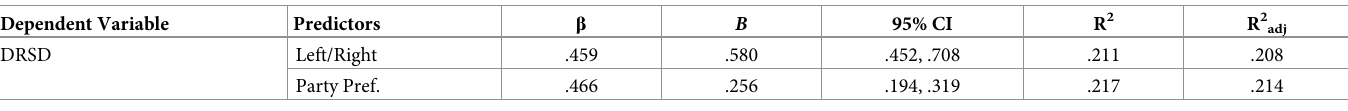
Table 3. Regression analyses predicting